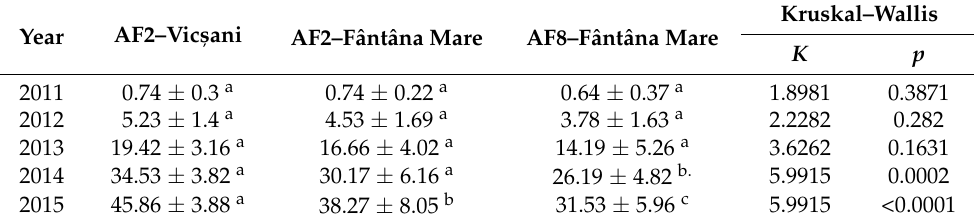
Table 2. The total biomass per hectare (Mg) cumulated after five growing seasons (average ± s.d.).